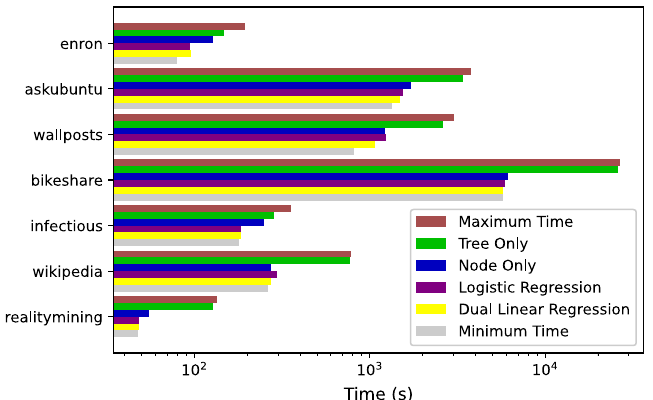
Fig. 5 Compound slice times for different approaches on IntervalGraph. Our proposed logistic and dual linear regression predictive compound slicing approaches perform better than using only node- or tree-based